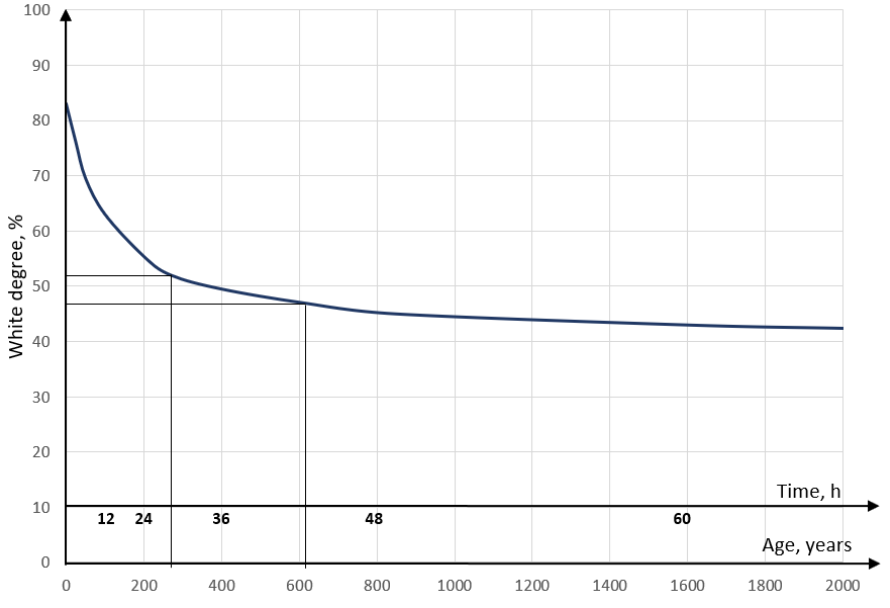
Figure 6. White degree standard curve.